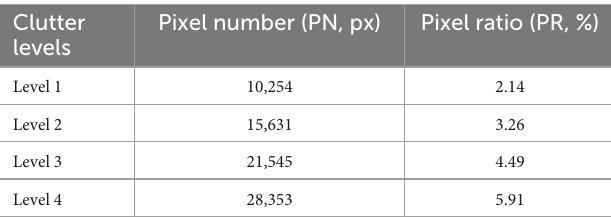
TABLE 3 Pixel numbers and pixel ratio of each clutter